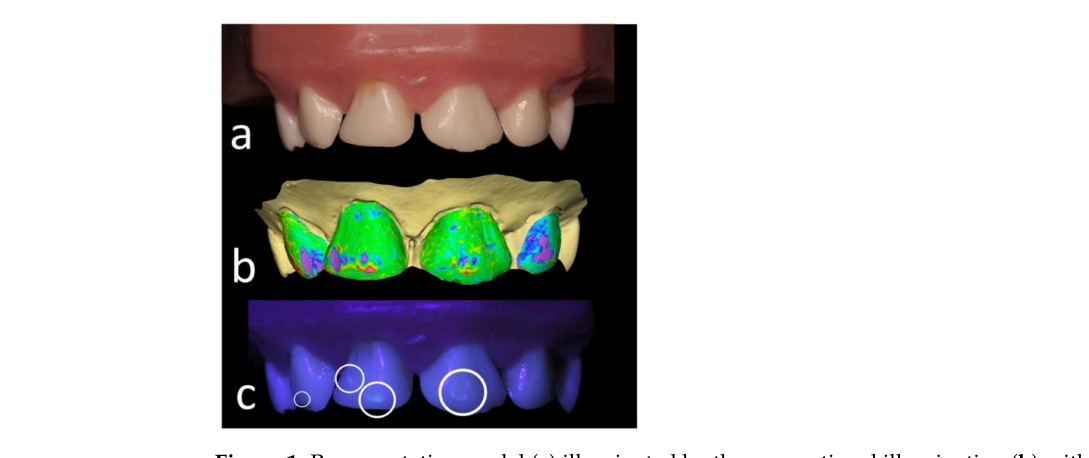
Figure 1. Representative model ( a ) illuminated by the conventional illumination ( b ) with visualized surface changes in the OraCheck software ( c ), illuminated by the fluorescence-inducing light source.